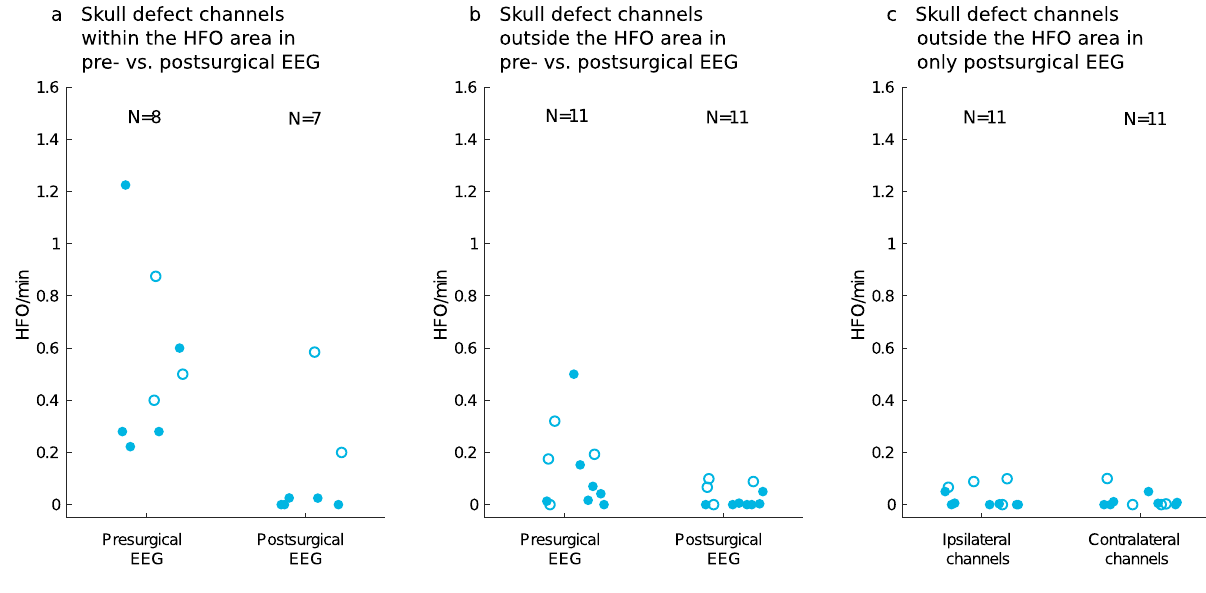
Figure 4. Scalp HFO rates of skull defect channels and their contralateral channels in presurgical and postsurgical EEG recordings. The patients for whom postsurgical seizure freedom was achieved (Engel I) are indicated by blue (full) circles, while patients with postsurgical seizure recurrence (Engel II–IV) are indicated by white (empty) circles. Of the 11 patients with skull defect channels, seven achieved postsurgical seizure freedom and four had postsurgical seizure recurrence. ( a ) Mean scalp HFO rates of skull defect channels within the HFO area significantly decreased (Wilcoxon signed-rank: p = 0.043, z = 2.023) from the presurgical (median 0.280 HFO/min, iqr 0.491) to the postsurgical EEG (median of 0.000 HFO/min, iqr 0.025) in the five patients for whom postsurgical seizure freedom was achieved. ( b ) Mean scalp HFO rates of skull defect channels outside the HFO area did not differ significantly (Wilcoxon signed-rank: p = 0.091, z = 1.690) between the presurgical (median 0.042 HFO/min, iqr 0.118) and postsurgical EEG (median 0.000 HFO/min, iqr 0.005) in the seven patients for whom postsurgical seizure freedom was achieved. ( c ) Mean HFO rates of skull defect channels outside the HFO area (median 0.003 HFO/min, iqr 0.063) did not differ significantly (Wilcoxon signed-rank: p = 0.726, z = 0.350) from their contralateral channels (median 0.003 HFO/min, iqr 0.011) in the postsurgical EEG of all patients, regardless of postsurgical seizure